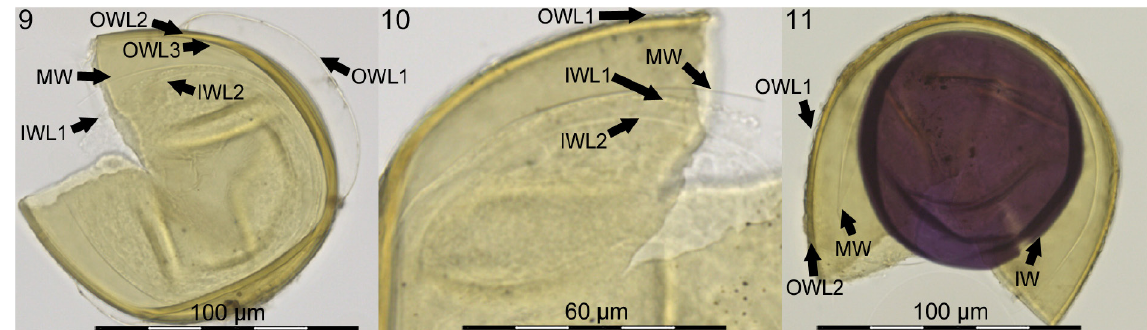
Figs. 9-11: Acaulospora dilatata. Crushed spores in PVLG or PVLG + Melzer’s reagent with three walls (OW, MW & IW) and multiple wall layers (OWL1-3, bi-layered MW, IWL2). OWL1 initially smooth (Fig. 9), getting roughened in the course of time (Figs. 10-11), sometimes resembling as finely pitted. IWL2 staining purple to dark purple in the presence of Melzer’s reagent.